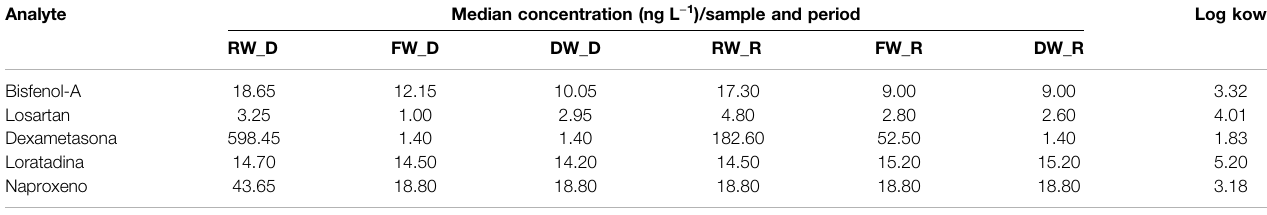
TABLE 5| Valuesofmedianconcentrationsofthe5micropollutantsmostfrequentlydetectedinthedry(_D)andrainy(_R)periodsinrawwater(RW), fi lteredwater(FW)and drinking water (DW) of WTP-Jataizinho. Analyte Median concentration (ng L − 1 )/sample and period